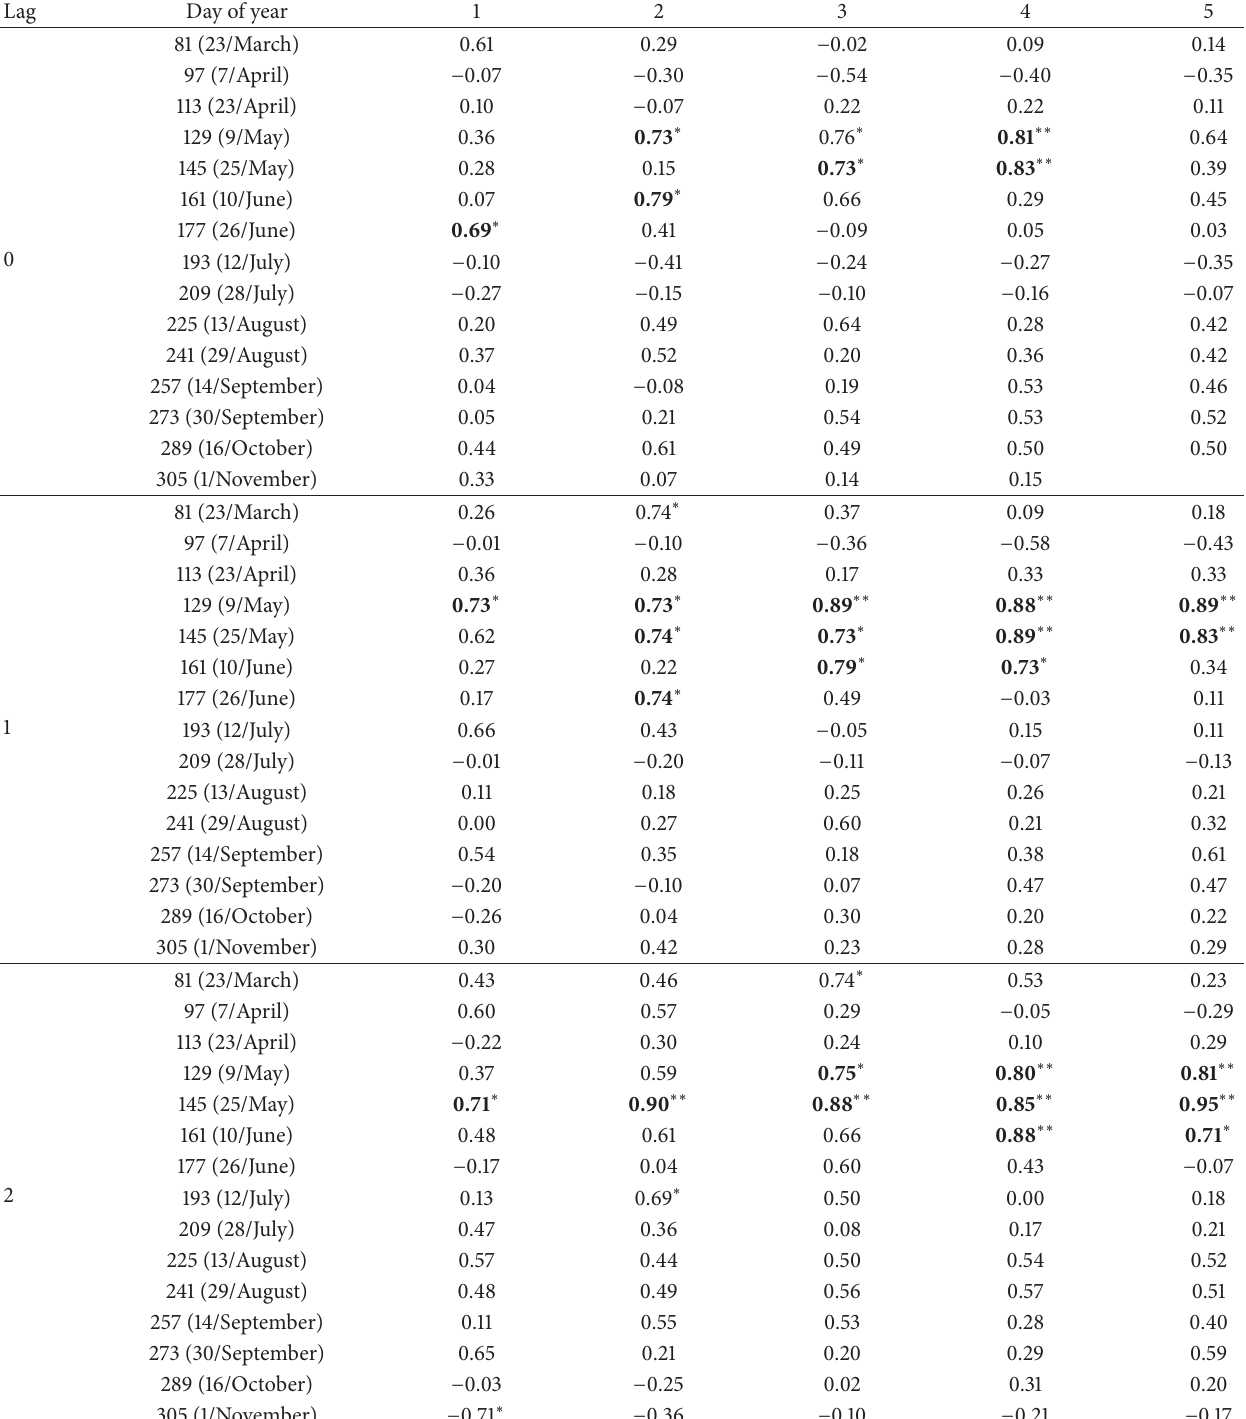
Table 3: Cross-season correlation coefficients between NDVI and precipitation in different combinations of time periods for the shrubland within Gurbantunggut Desert. The numbers in the first row indicated the periods for which precipitation was accumulated (1 indicated the current 16-day period, 2 indicated the sum of the current period and the first previous period, 3 indicated the sum of the current period, the first previous period, and the second previous period, etc.). The numbers in the first column indicated the time lags for the precipitation (0 indicated the current 16-day period, 1 indicated the first previous period,